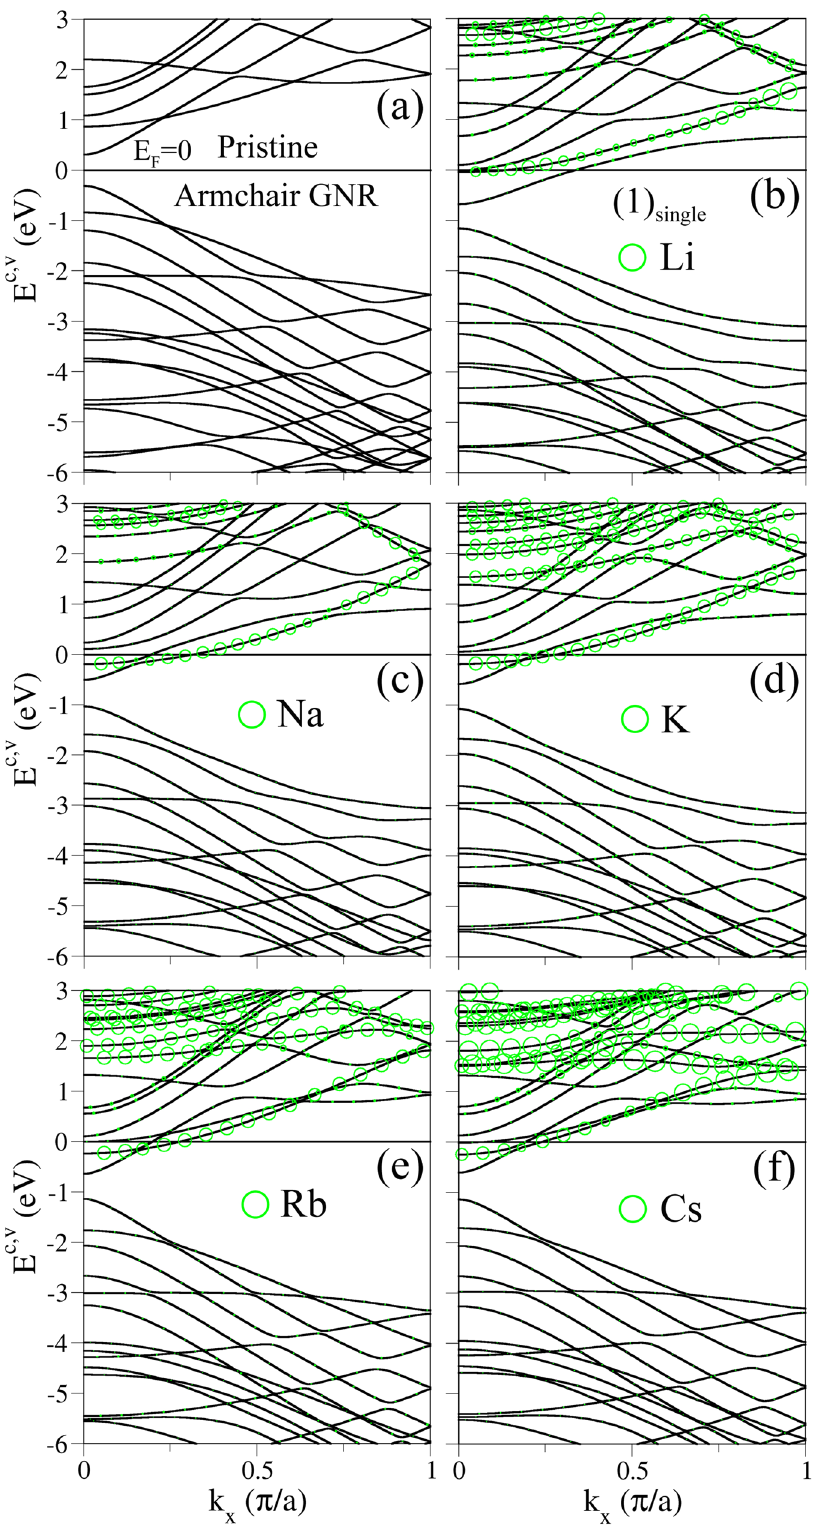
Figure 2. Band structures of N A = 12 armchair systems for ( a ) a pristine GNR, and the ( b ) Li-, ( c ) Na-, ( d ) K-, ( e ) Rb- and ( f ) Cs-adsorbed GNRs with an adtom at edge. Green circles represent the contributions of alkali